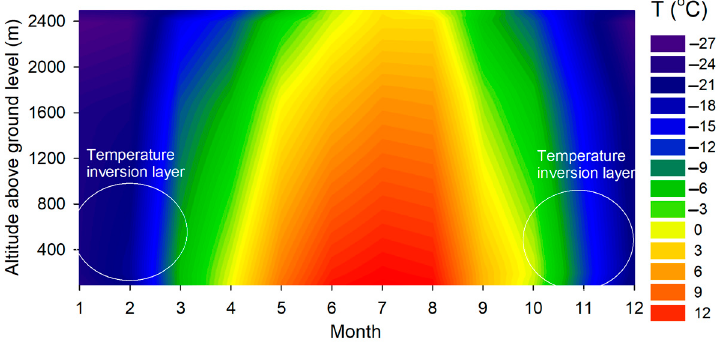
Figure 9. Monthly air temperature patterns of the lower troposphere over Ulaanbaatar city (1991– 2020).